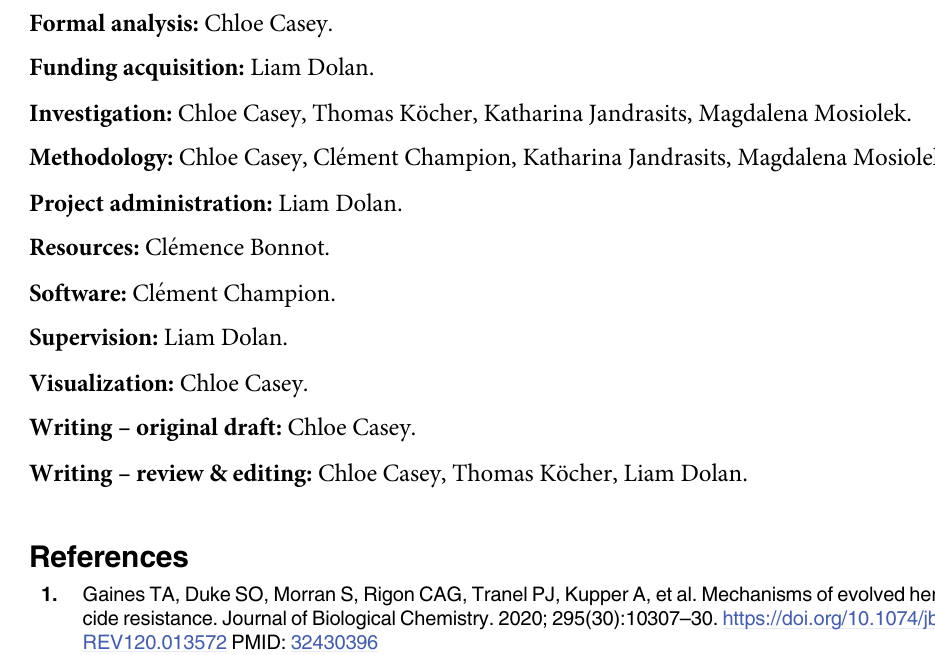
S1 Table. Numerical data underlying graphs and summary statistics. S2 Table. Homologues of the A . thaliana gene AT3G59280 identified by BlastP search (E value < 1E-5). S3 Table. Primer